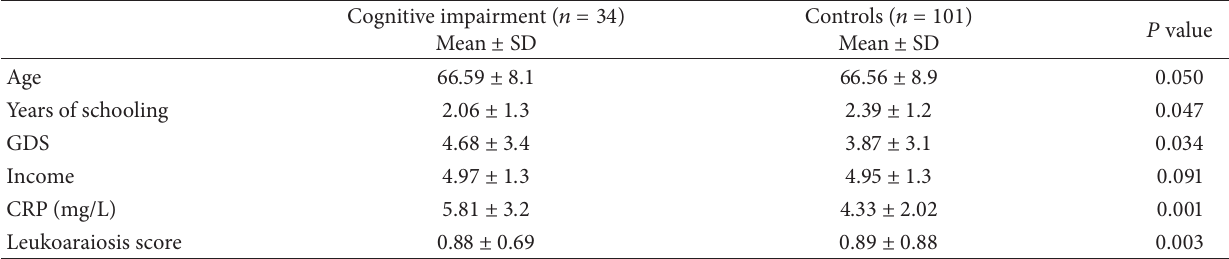
Table 1: Student’s 𝑡 -test for numeric variables.